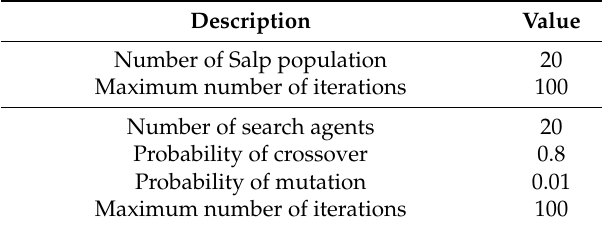
Table 2. Considered parameters of the SSA and